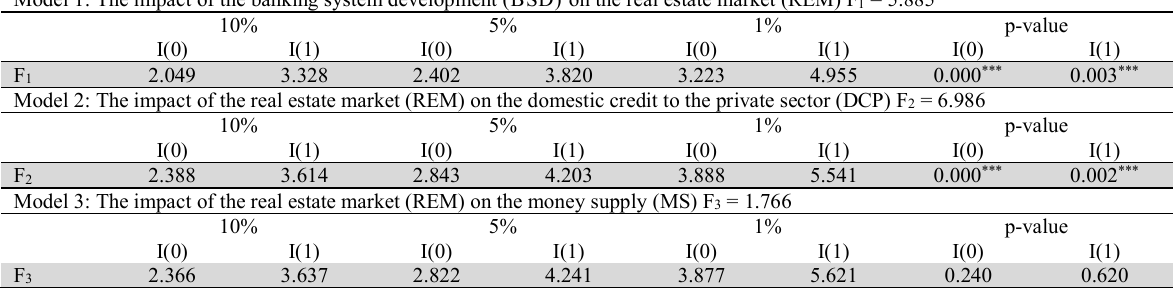
Results of cointegration test